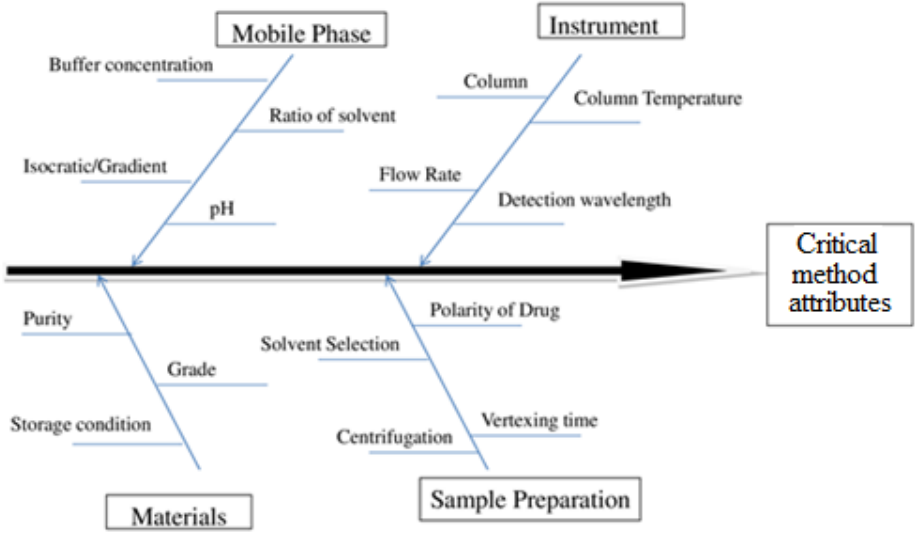
Figure 1. Factor affecting the critical method